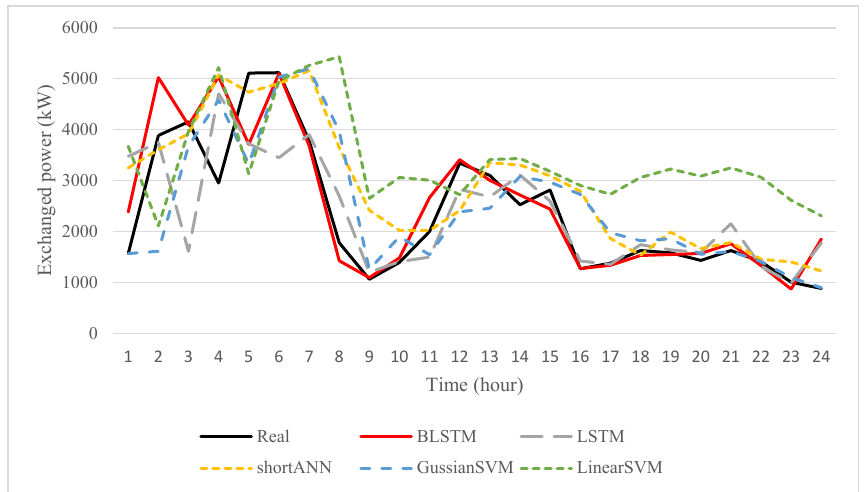
Figure 5. Amount of exchanged power between VPP and upstream network.